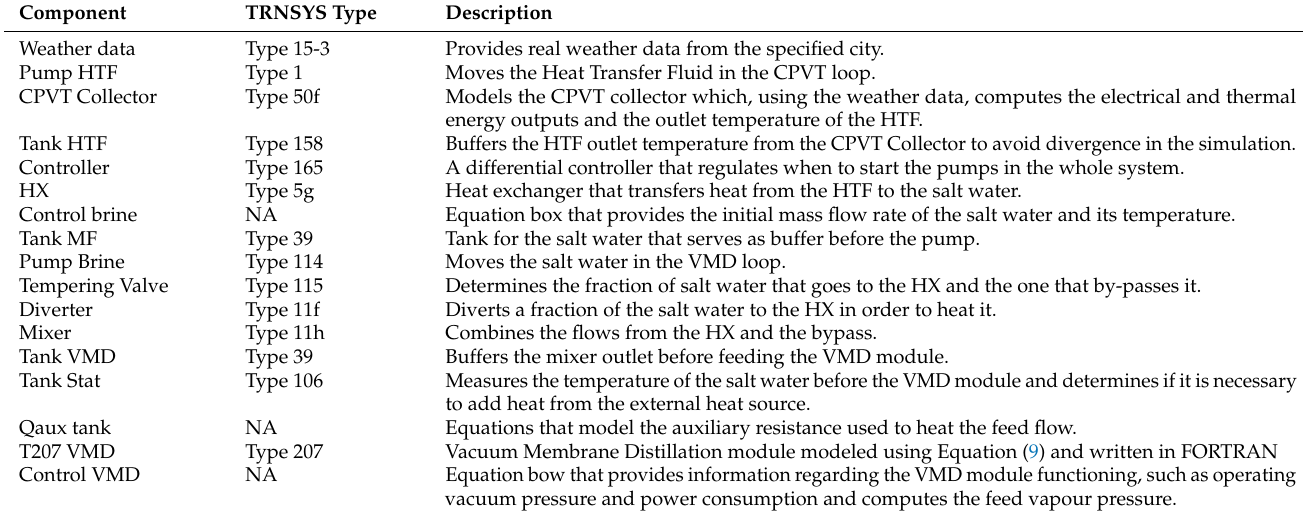
Table A1. Components used in the TRNSYS